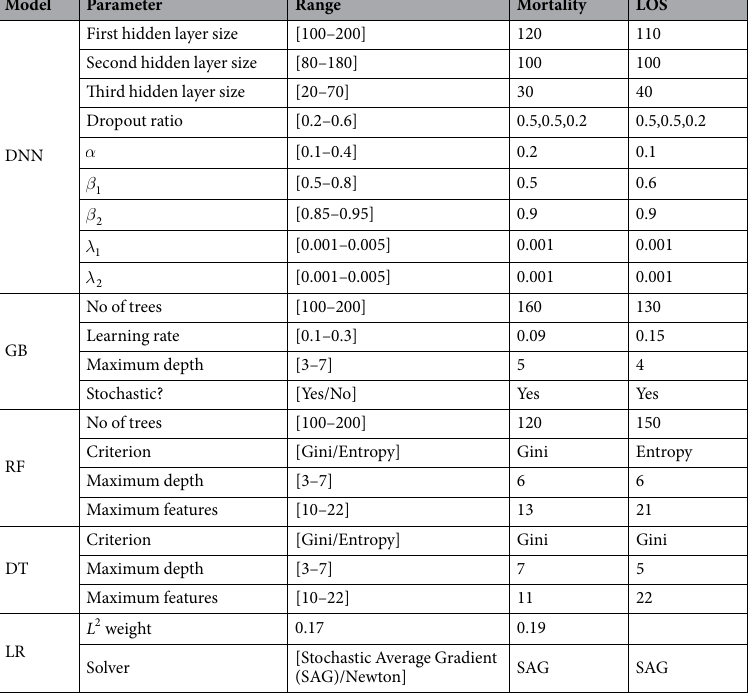
each model. The ROC curve plots the true positive rate (TPR), also known as sensitivity, versus the false positive rate (FPR), or 1-specificity, at various threshold selections. AUROC is equal to the probability that a classifier will rank a randomly chosen positive instance higher than a randomly chosen negative one. The F-score is the har- monic mean of precision (positive predictive value) and recall (sensitivity) and is considered the most important performance measure for a machine learning model as it incorporates a measure of precision and recall values. Although the 549 patient records from the PHN SVR dataset are an acceptable volume of data to train unbi-